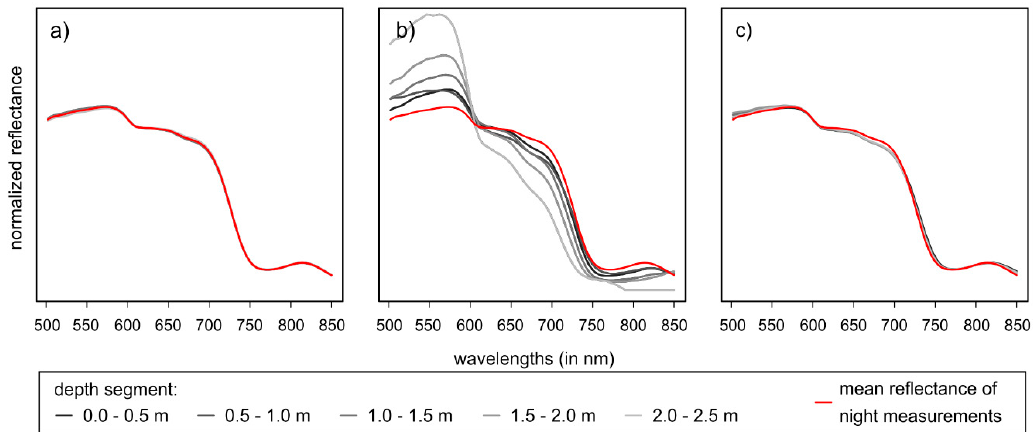
Figure 7. Comparison of reflectance spectra acquired at Cospuden site during a ) nighttime measurements, b ) daytime measurements without compensation for sunlight attenuation, and c ) daytime measurements with compensation for sunlight attenuation.